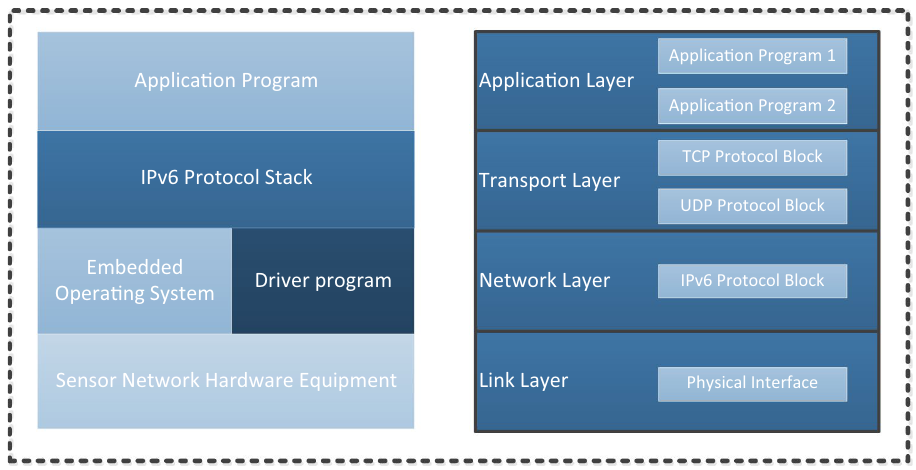
Figure 6. The position and layered model of the IPv6 protocol stack in the